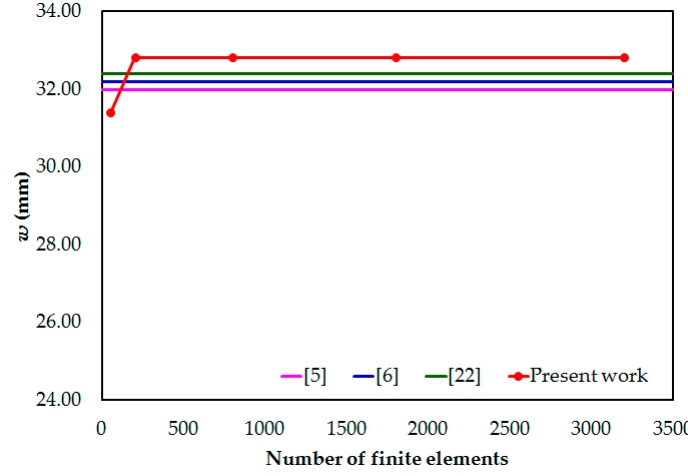
Figure 2. Non-stiffened plate computational model verification.